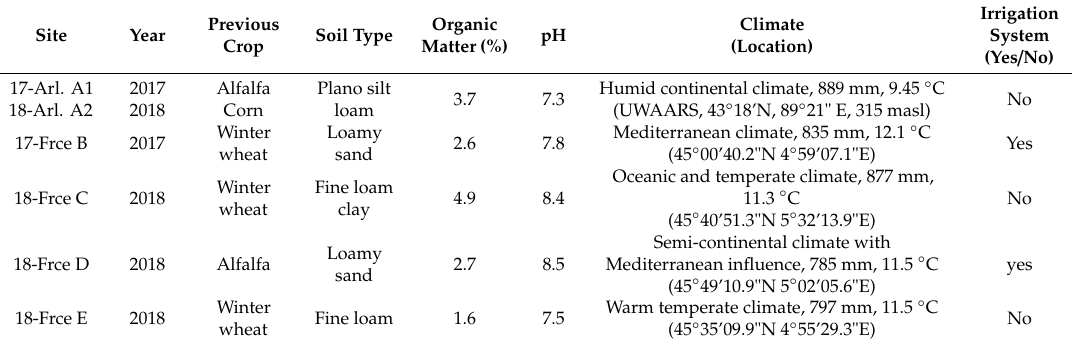
Table 1. Description of the six experimental sites (soil and climate